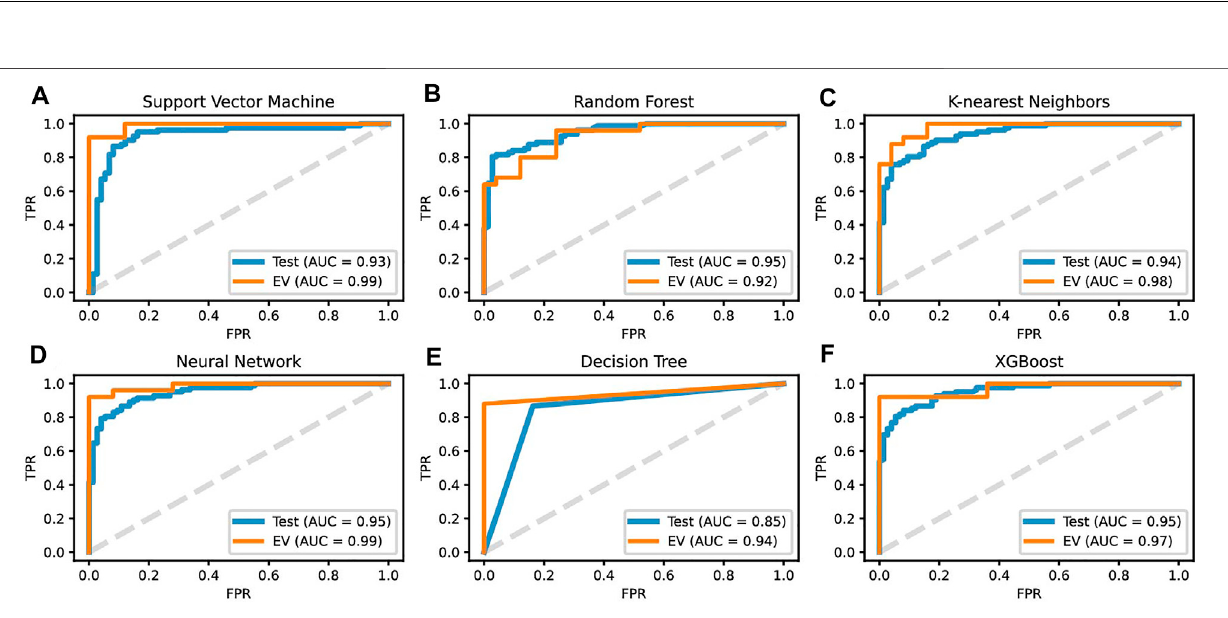
Frontiers in Physiology |